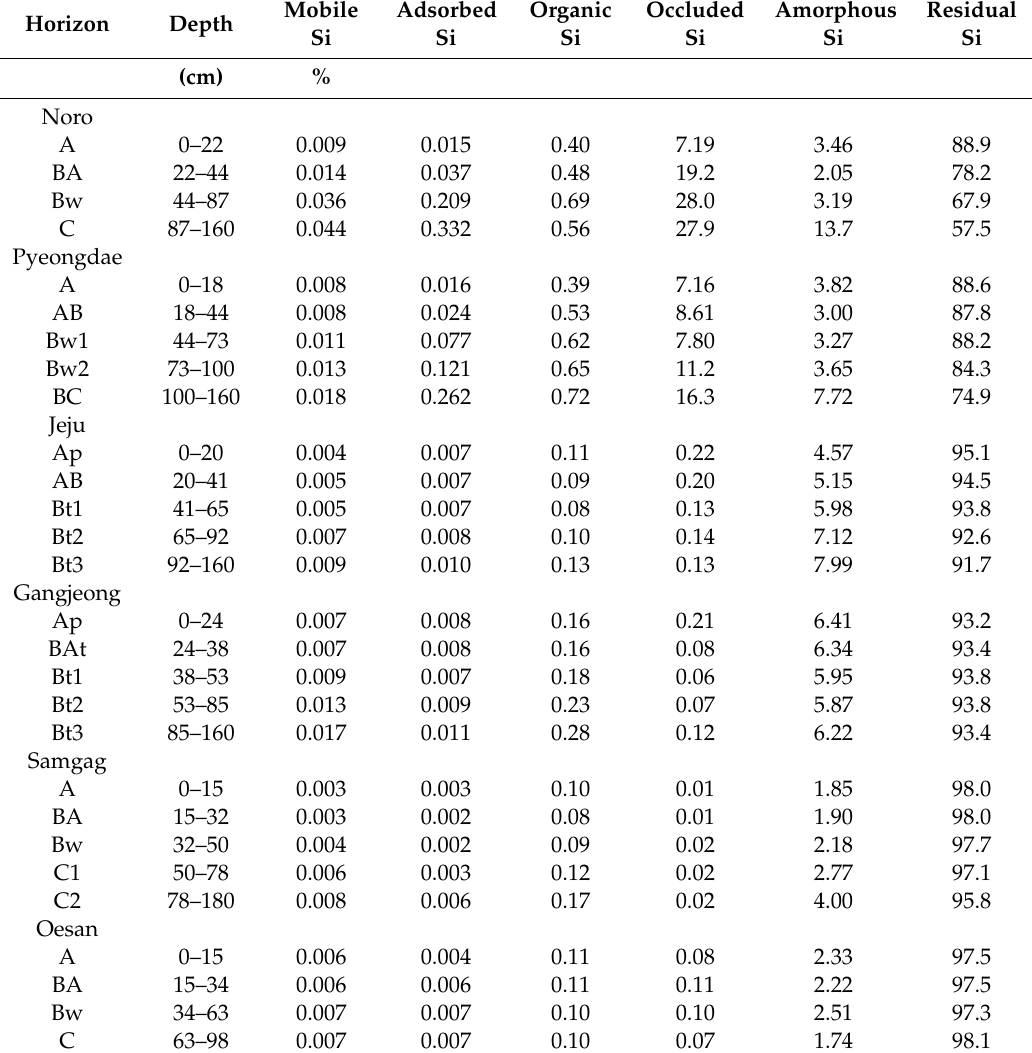
Table 7. Distribution of di ff erent Si fractions by sequential